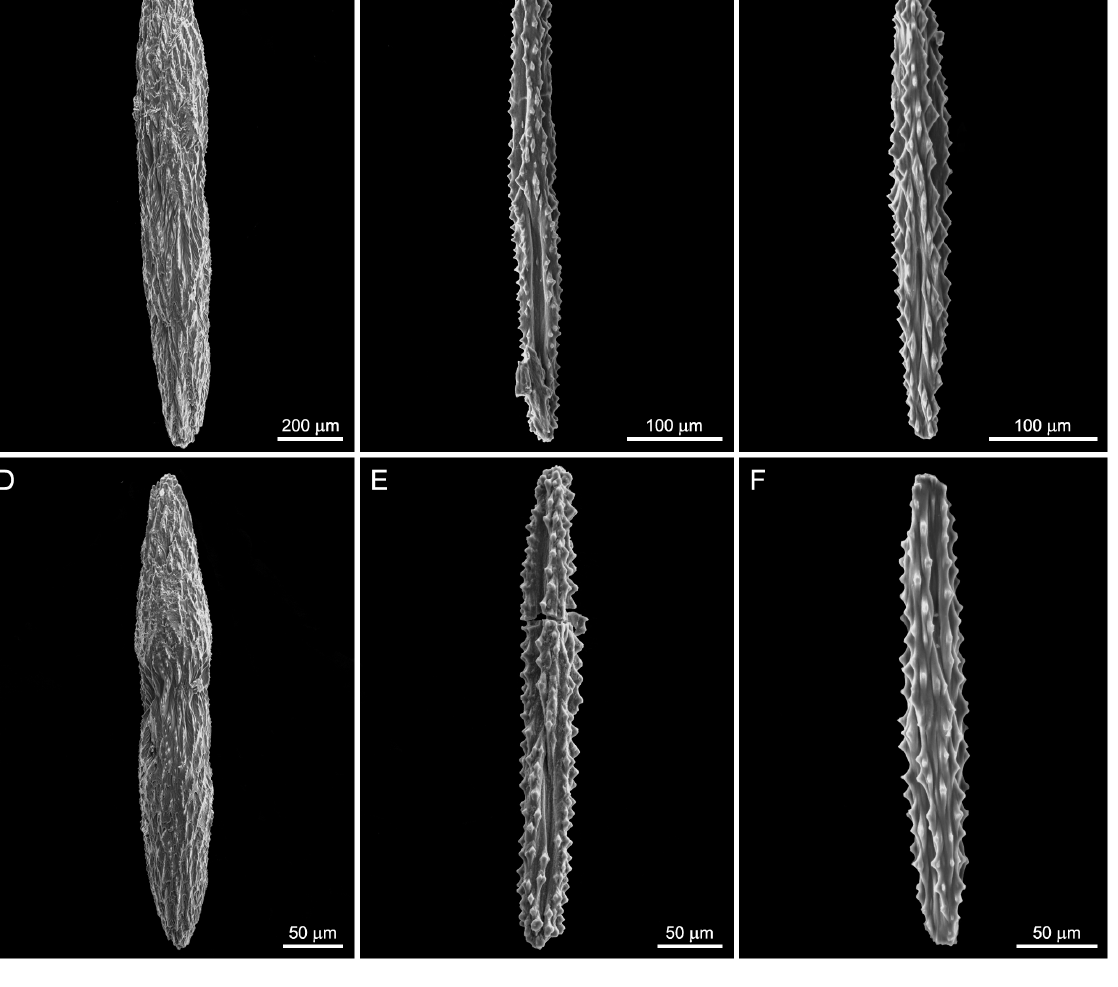
Fig. 5. Variability of sizes and ornamentations of the polyps’ sclerites of the holotype of Umbellula pomona Risaro, Williams & Lauretta sp. nov. (MACN-IN